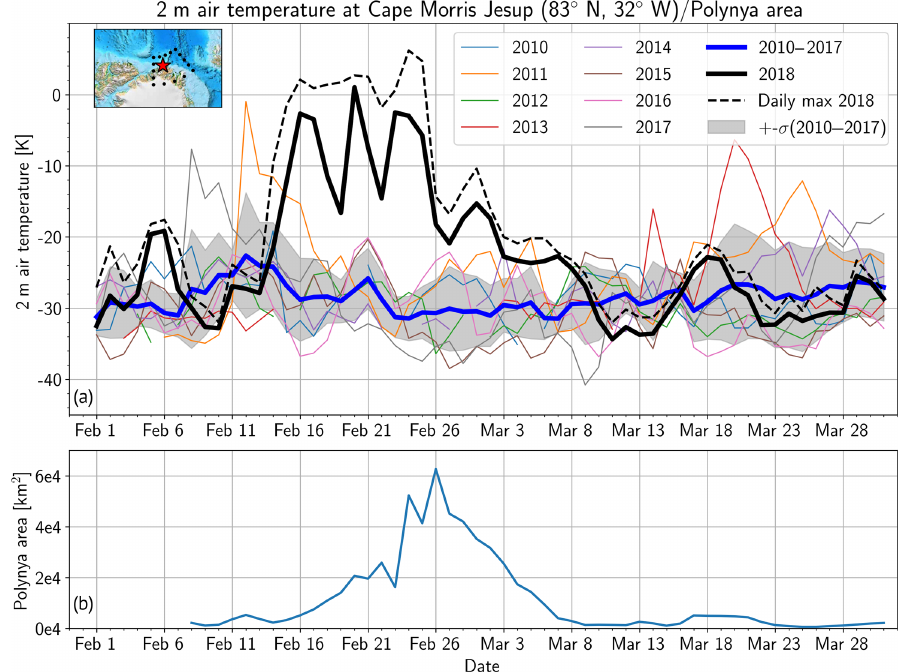
Figure 6. (a) Daily average of 2m air temperature data at the Danish Meteorological Institute’s weather station at Cape Morris Jesup since 2010. The blue line shows the mean air temperature of the years 2010–2017, and the black line shows the air temperatures in 2018. The thin lines represent the single years. The shading indicates the standard deviation of the air temperatures in the years 2010–2017. The box and star in the map mark the region of the polynya event and the location of the Cape Morris Jesup station, respectively. (b) Time series of the polynya area are from Fig. 5 but with daily means instead of all